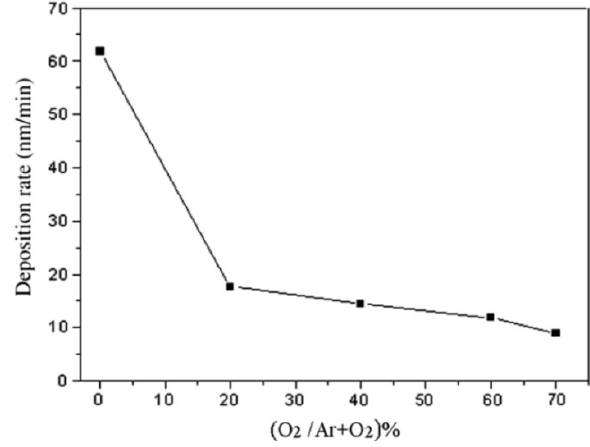
Figure 7. Deposition rate of TiO 2 films as a function of oxygen partial pressure at a constant sputtering pressure (10 mTorr). Reprinted with permission from [74], copyright 2010, Elsevier. The grain size and root-mean-square (RMS) surface roughness of TiO 2 films are affected by the argon/oxygen ratio in magnetron sputtering [37,76,87,104,106]. Argon is the main sputtering gas that